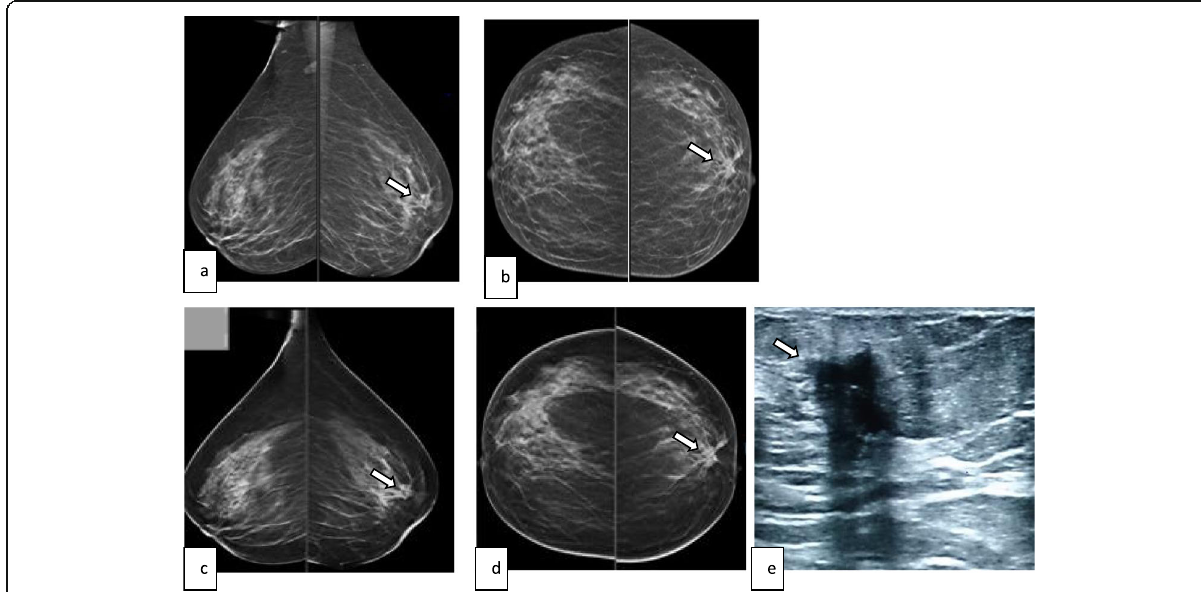
Fig. 8 (Case no. 1) A 52-year-old patient presented by mastalgia and palpable mass in the left breast. Mammography revealed breast density: ACR B and left retro-areolar focal asymmetry assigned as (BIRADS 4) ( a , b ). 3D tomosynthesis revealed: left retro-areolar speculated mass lesion is seen (BIRADS5) ( c , d ). Breast ultrasound revealed: an irregular speculated hypoechoic mass lesion with posterior shadowing (BIRADS 5) ( e ). Final diagnosis: invasive duct carcinoma